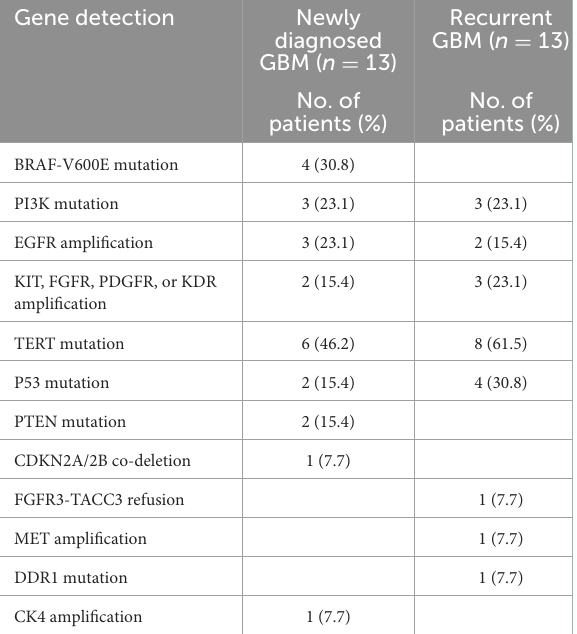
TABLE 4 The gene detection of TTFields group. Gene